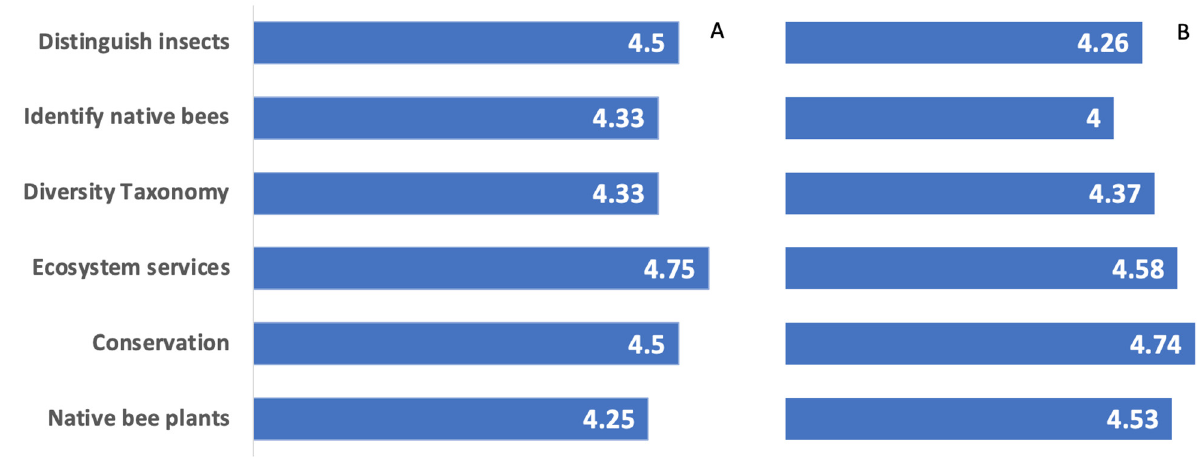
Figure 4. Specific Perceived Knowledge Gains Mean ratings per topic across all participants in ( A ) 2018 and ( B ) 2019 on a 5-point scale (1—strongly disagree, 2—disagree, 3—neutral, 4—agree, 5—strongly agree), where participants rated each of the following 6 specific topics (learning objectives) based on the statement, “As a result of the course, I’m better able to . . . ” (see Supplementary Tables S6 and S7).